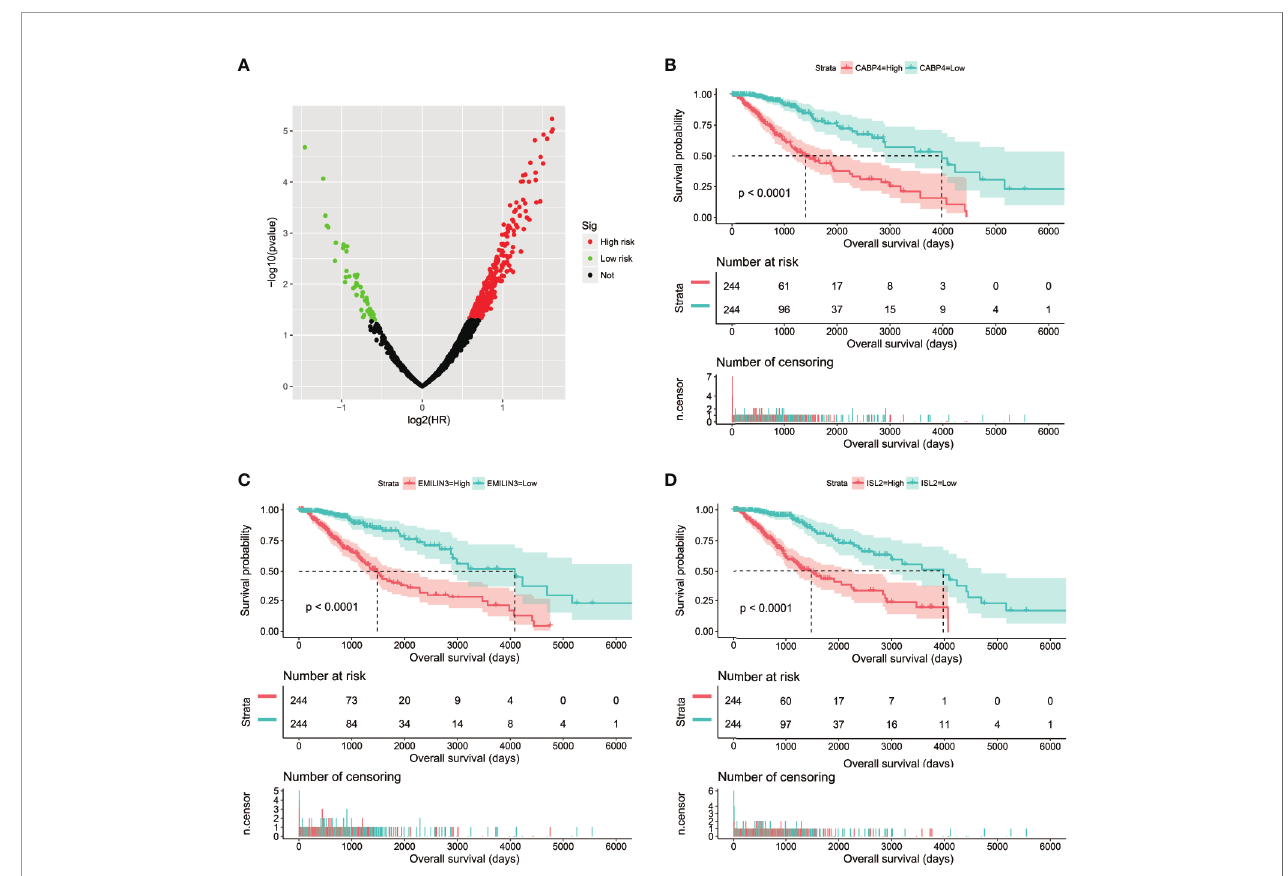
FIGURE 9 | Survival analysis results of DEGs between high- and low-risk score phenotypes in TCGA LGG cohort. (A) Volcano plot of DEGs survival analysis results; (B) Kaplan – Meier survival curves of CABP4; (C) Kaplan – Meier survival curves of EMILIN3; (D) Kaplan – Meier survival curves of